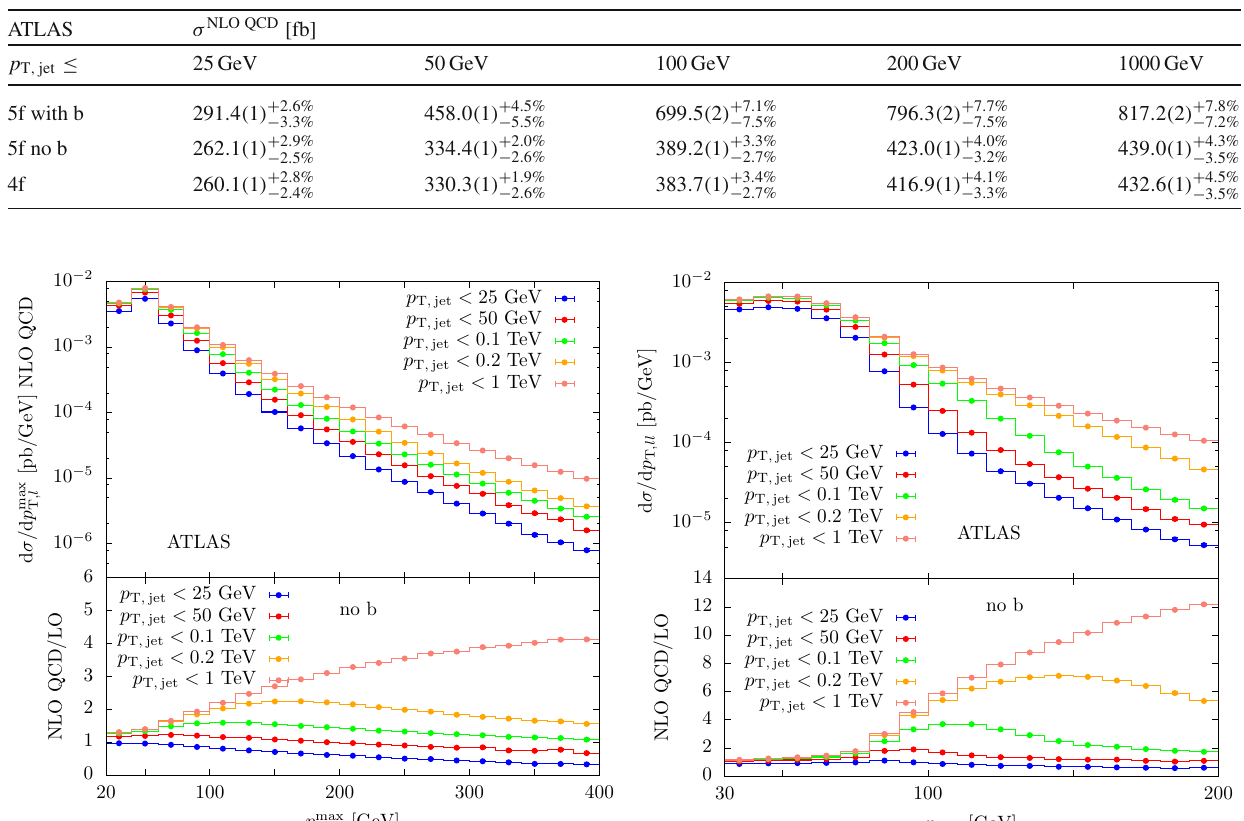
with initial-state b-quark contribution included. These contributions are omitted in the results in the fourth line (5f no b). In the last line the